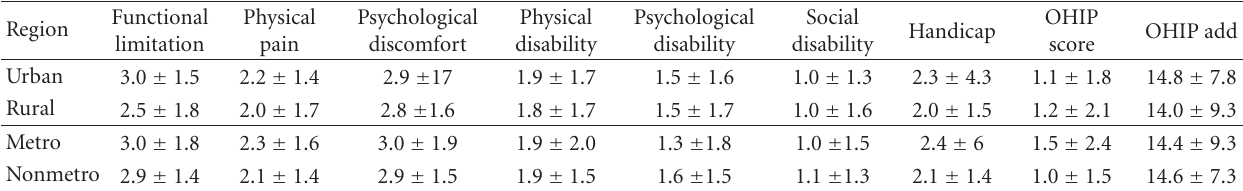
Table 2: Mean OHIP-14 for the subscales and total scores according to